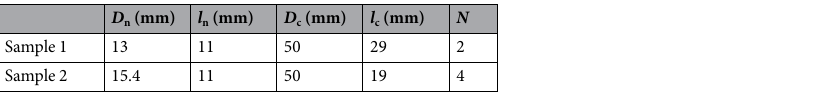
Table 1. Geometric parameters of the